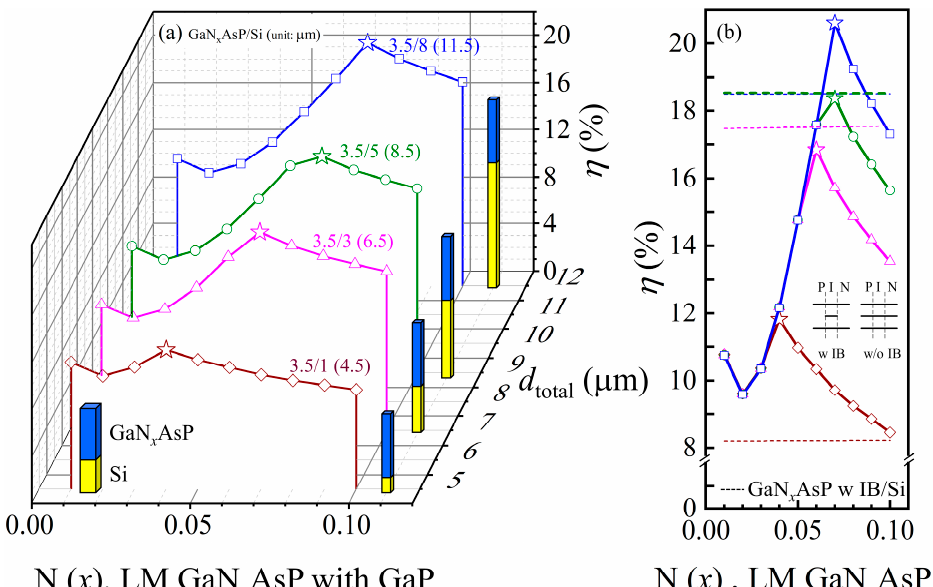
Figure 7. ( a ) PCEs ( η ) of the GaP-lattice-matched GaN x AsP/Si tandem cell as a function of N concentration ( x ) with the different total thickness ( d total ). The schematic diagrams of the tandem cell are plotted in the figure. The thickness of each cell is labeled above the curve; ( b ) PCEs of GaP-lattice-matched GaNAsP/Si tandem cell as a function of nitrogen concentration ( x ). The dashed lines represent the PCE of GaP-lattice-matched GaN x AsP IBSC with E − c band as IB and GaP as the top cell’s P- and N- region’s material. The schematic diagrams of band structure with or without IB also plotted.